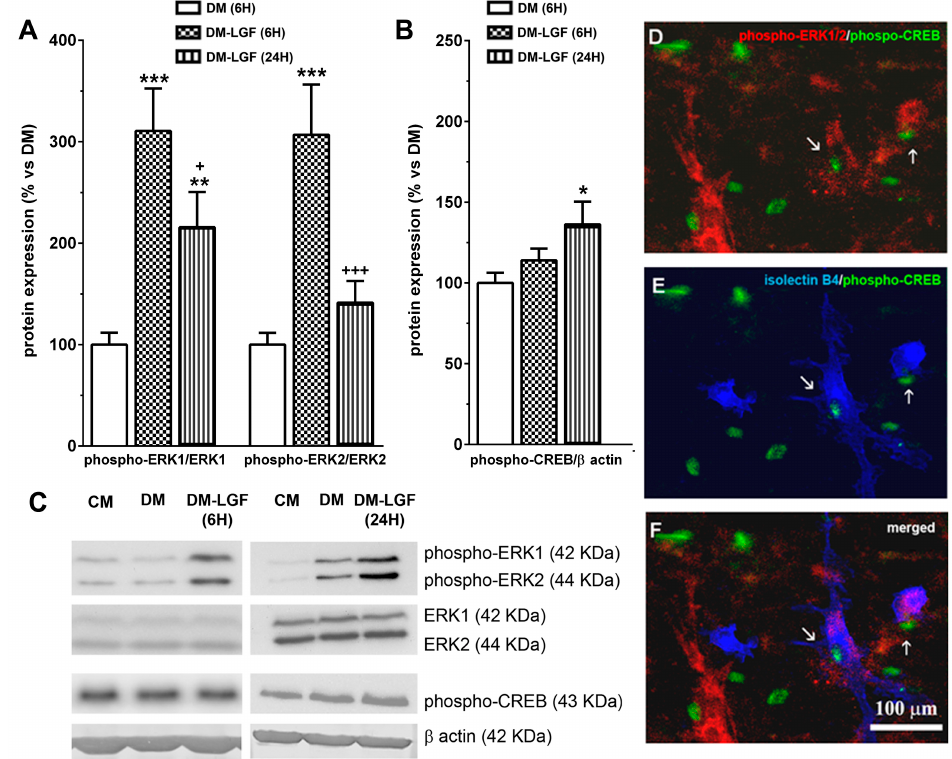
Figure 4. E ff ects of LGF on ERK1 / 2 and CREB phosphorylation in cultured mesencephalic glia. ( A ) shows the e ff ect of LGF on phospho-ERK1 / ERK1 and phospho-ERK2 / ERK2 ratios in mesencephalic glia maintained in a DM (white bar) ( A ) and in a defined medium with LGF (DM and LGF) for 6 (dots bar) or 24 h (black bar). Note how LGF increased the phospho-ERK1 / ERK1 ratio at both experimental times. ( B ) shows the e ff ect of LGF treatment in phospho-CREB protein expression in DM (white bar) and in a defined medium with LGF (DM and LGF) for 6 (dots bar) or 24 h (vertical black lines bar). Note how LGF treatment for 24 h significantly increased phospho-CREB levels. ( C ) shows representative bands of phospho-ERK1 / 2, ERK1 / 2, phospho-CREB, and β -actin. Note how ERK1 / 2 protein levels are unchanged under all experimental conditions. ( D – F ) show how some phospho-CREB-positive cells—( D – F ) in green—were also immunopositive for phospho-ERK1 / 2 ( D ) (red) and isolectin IB4 ( E ) (blue), as well as how a few isolectin IB4-positive cells were phospho-ERK1 / 2- and phospho-CREB-positive too ( F ). Results in ( A , B ) represent the mean ± SEM of 5–9 independent experiments. * p ≤ 0.05, ** p ≤ 0.01, *** p ≤ 0.001 vs. DM, + p ≤ 0.05, +++ p ≤ 0.001 vs. 6 h DM and LGF (ANOVA and Newman–Keuls). In ( C ), lane 1 and 4: CM; lane 2 and 5: DM; lane 3: DM and LGF (6 h); and lane 6: DM and LGF (24 h). Scale bar 100 µ